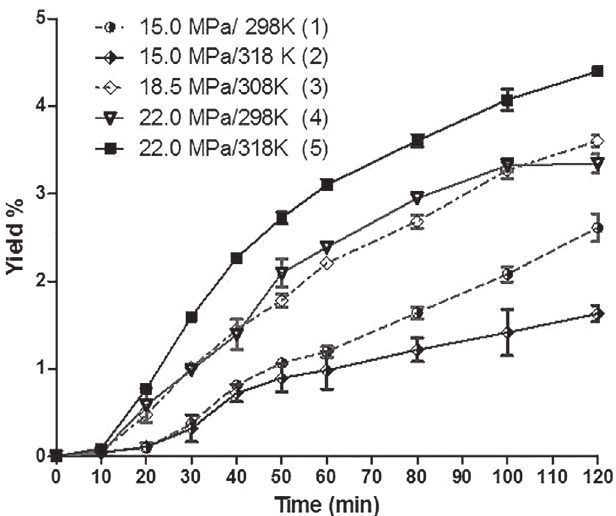
FIGURE 1 - Kinetic of extraction (crude yield x time) obtained by SFE in different temperature and pressure